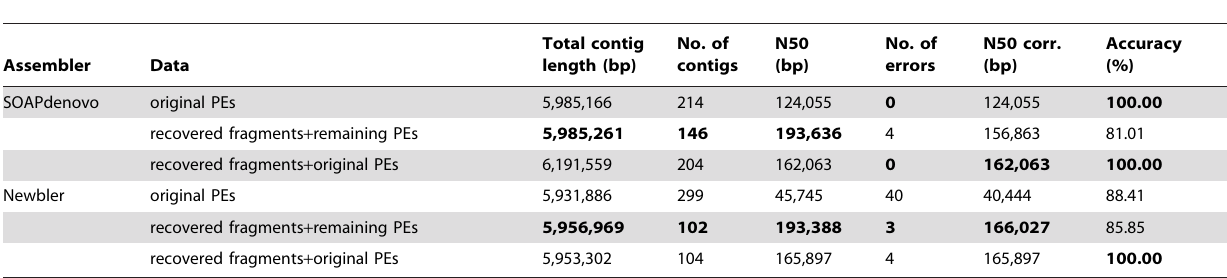
Table 5. Statistics of SOAPdenovo and Newbler assemblies on three types of simulated data of P. brasiliensis .